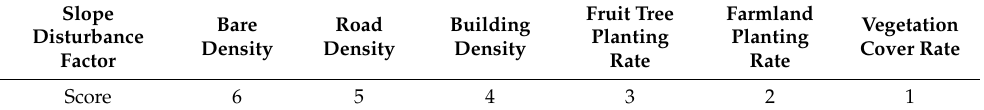
Table 8. Evaluation index values of the slope disturbance factors that affect landslide occurrence